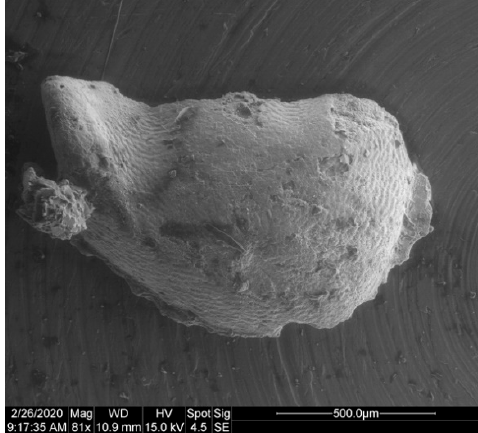
Figure 32. Cambroarchilocus tigris gen. nov. sp. nov. Holotype. Left shield, detail of posterodorsal node and posterior cardinal corner. Anterior to left. IGM 3614 (42). Photo Credit: Mark McMenamin.